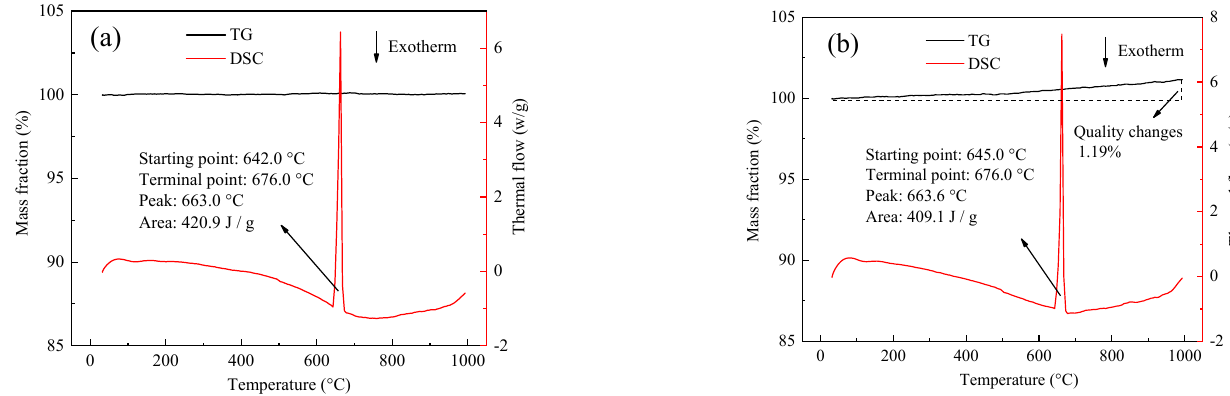
Figure 4. TG/DSC curve of wires in an air atmosphere: ( a ) aluminum alloy wires; ( b ) aluminum wires.